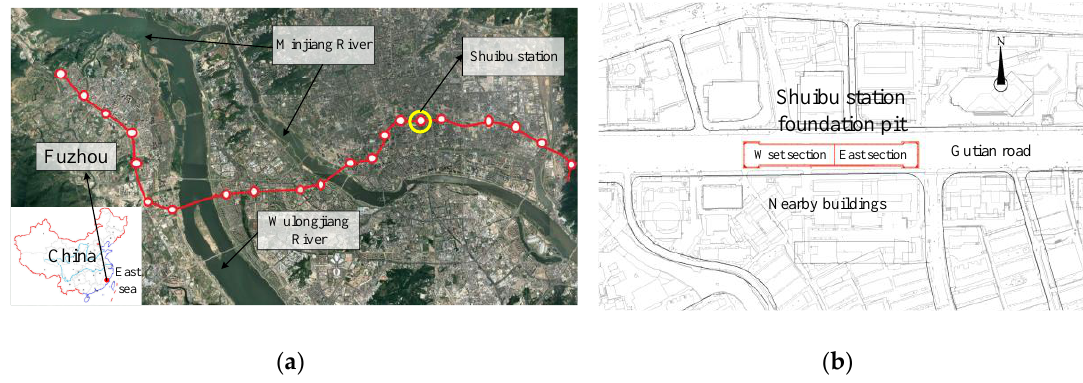
Figure 1. ( a ) Geographical location of the study site. ( b ) Plan view of the foundation pit.